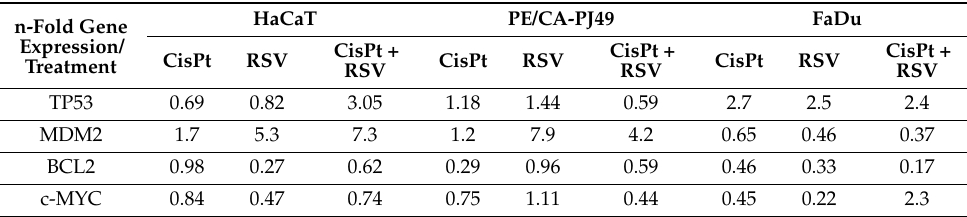
Figure 2. The effect of CisPt and/or RSV treatment on gene expression (( A )—TP53; ( B )—MDM-2; ( C )—BCL-2; ( D )—C-MYC) in tumor cells PE/CA-PJ49 and FaDu compared to normal HaCaT cells. The results were obtained using gene reference HPRT (hypoxanthine phosphoribosyltransferase). Control is represented by the untreated cells of each cell line and the n-fold expression for each gene analyzed in control cells is 1. Each sample was performed in duplicate. The samples were analyzed using the formula 2- ∆∆ Ct = gene expression. (* p < 0.05, ** p < 0.005, *** p < 0.0005). Table 3. n-fold gene expression in PE-CA/PJ49 or FaDu tumor cells versus normal HaCaT cells treated for 24 h with 10 µ M CisPt and/or 50 µ M RSV. The results were obtained using gene reference HPRT. Control is represented by the untreated cells of each cell line, and the n-fold expression for each gene analyzed in control cells was